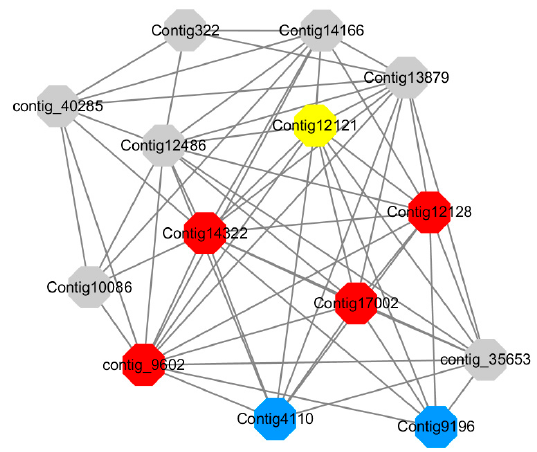
Figure 19. GCN of Module 14.